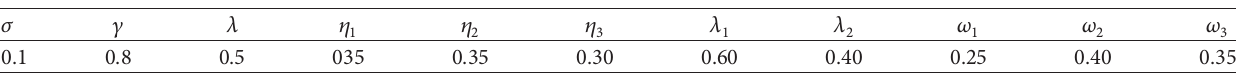
Table 7: Parameters selection for